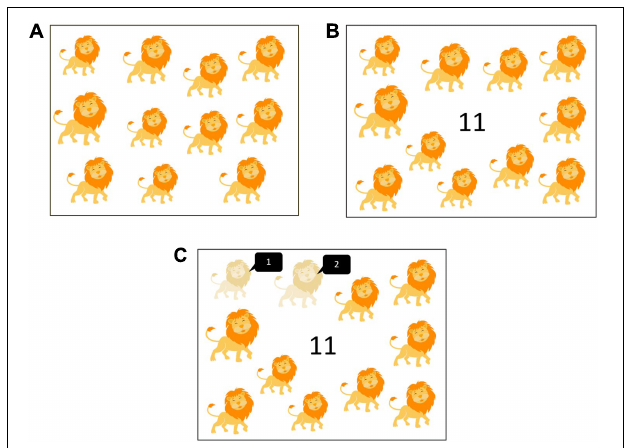
FIGURE 1 | The pictures used in different conditions. In (A) control condition, only pictures were shown. In (B) label condition, an Arabic number representing the quantity of items appeared at the center. In (C) label-and-count condition, the narrator clicked on the mouse to lighten each item while he counted with the children. The black conversation boxes were not shown in the actual